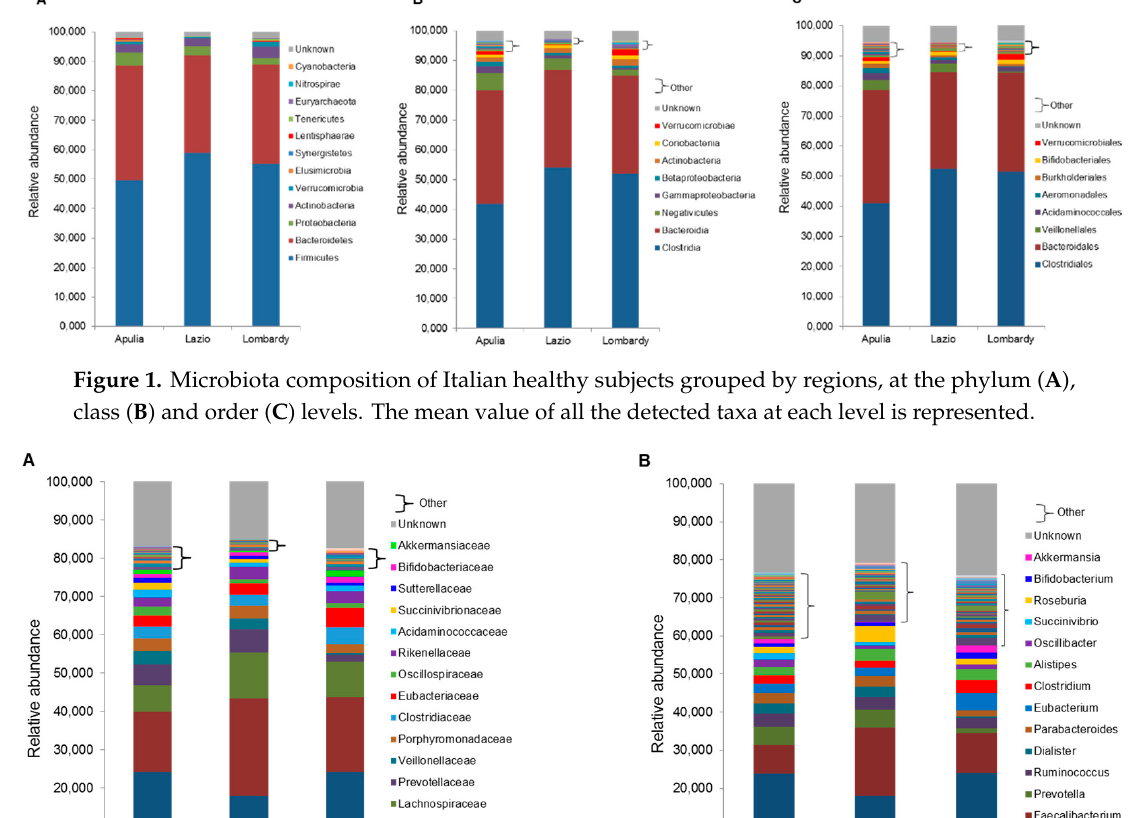
(( A )—family level, ( B )—genus level; species level not shown)).